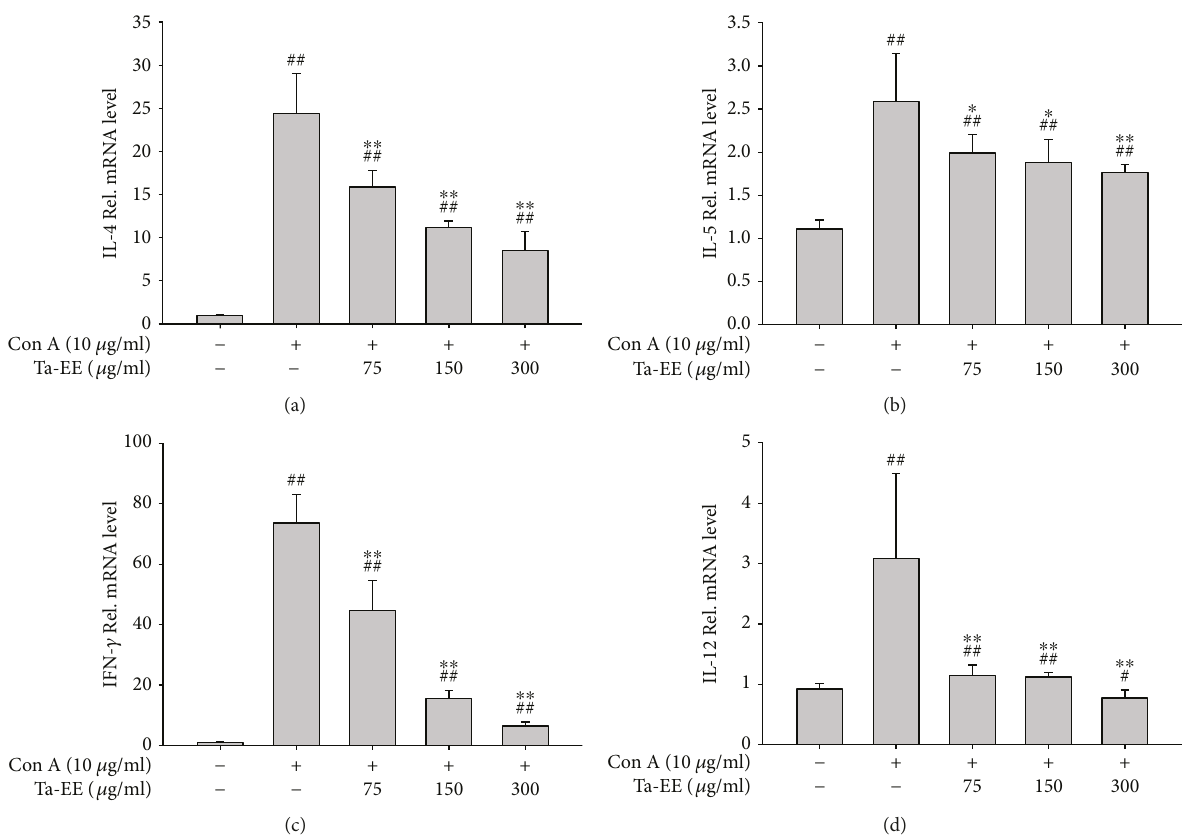
Figure 4: E ff ects of Ta-EE on mRNA expression of proin fl ammatory cytokines in Con A-stimulated splenocytes. The total splenocytes isolated from the spleens of normal mice pretreated with Ta-EE (0, 75, 150, and 300 μ g/ml) for 30min were treated with Con A (10 μ g/ml) for 6h. The mRNA expression levels of (a) IL-4, (b) IL-5, (c) IFN- γ , and (d) IL-12 in the splenocytes were determined using quantitative real-time PCR. ∗ P < 0 05 and ∗∗ P < 0 005 versus a control group; # P < 0 05 and ## P < 0 005 versus a normal